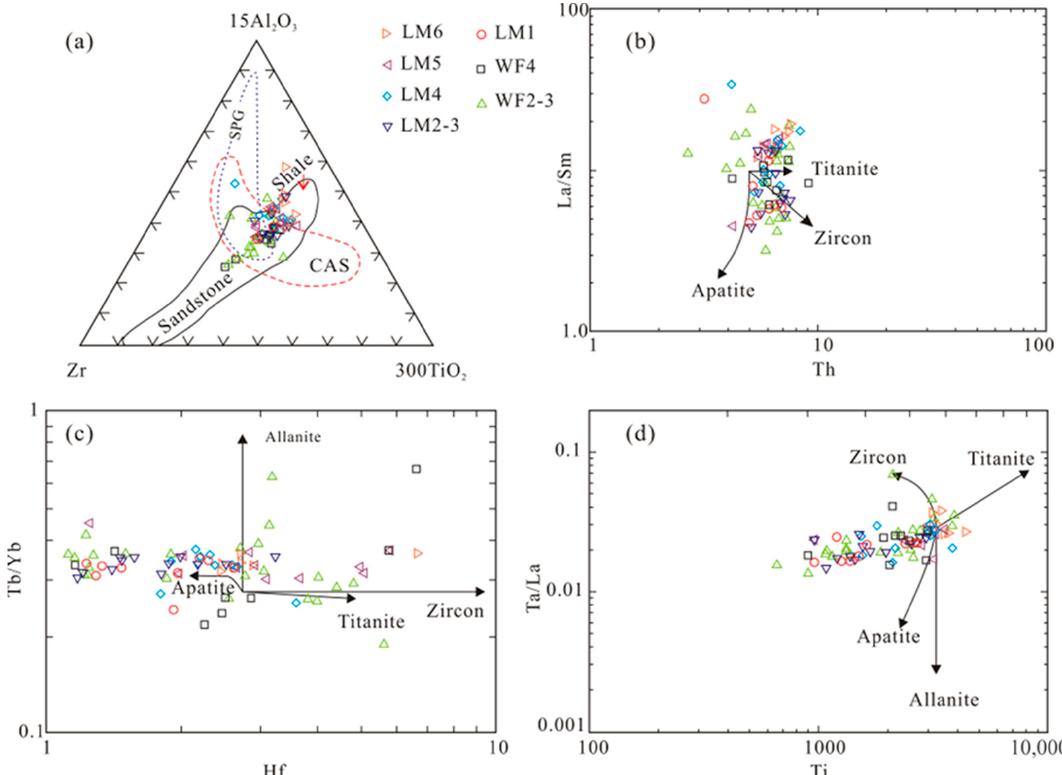
Figure 12. ( a ) Al–Ti–Zr triangular diagram [55]; ( b ) La/Sm–Th, ( c ) Tb/Yb–Hf, and ( d ) Ta/La–Ti bivariate diagrams [56] showing the effects of sedimentary sorting. In the figure, CAS refers to the field of calc-alkaline suites, and SPG refers to strongly peraluminous